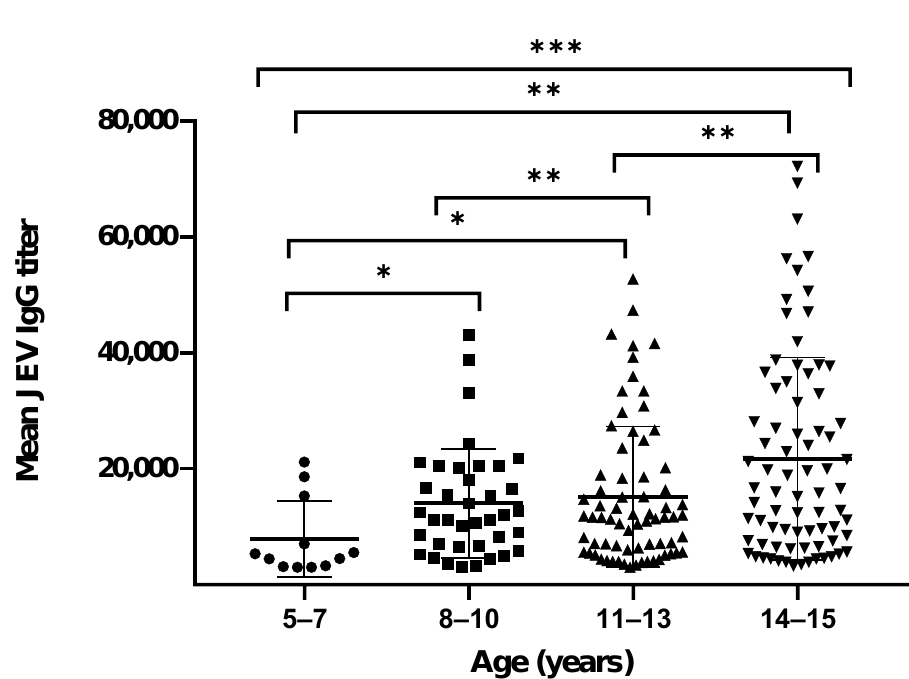
Figure 1. Distribution of anti-JEV IgG antibody titers among different age groups. A p value less than 0.05 is considered statistically significant (* p < 0.05; ** p < 0.01; *** p < 0.001).